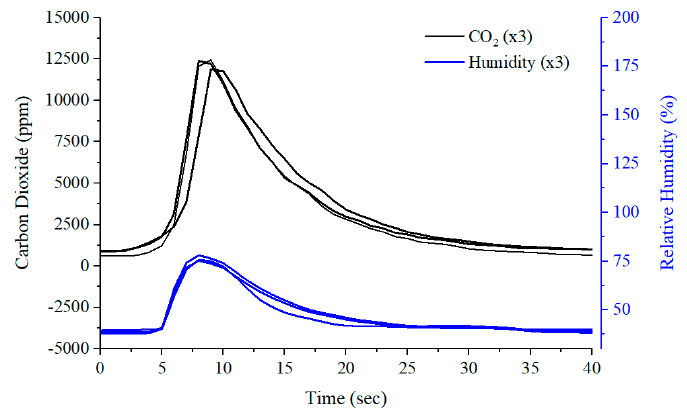
Figure 11. Breath sampling reproducibility using carbon dioxide and humidity sensor readings.